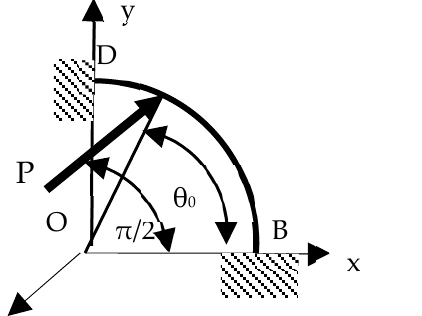
Figure 2. Mathematical model of mandible body as a quarter of a circle loaded with P , a concentrated vertical force which acts perpendicular to the plane of a spring.